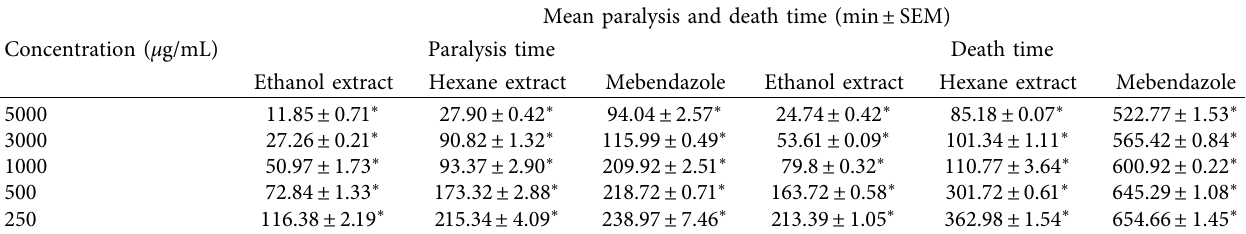
Table 2: Anthelmintic activity of ethanol and hexane extracts of O. basilicum .